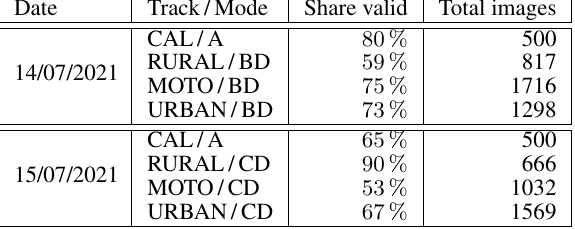
Table 1. Share of valid aerial images of each scenario compared to the total number of images acquired with 50mm focal length. The modes are listed in Table 2.